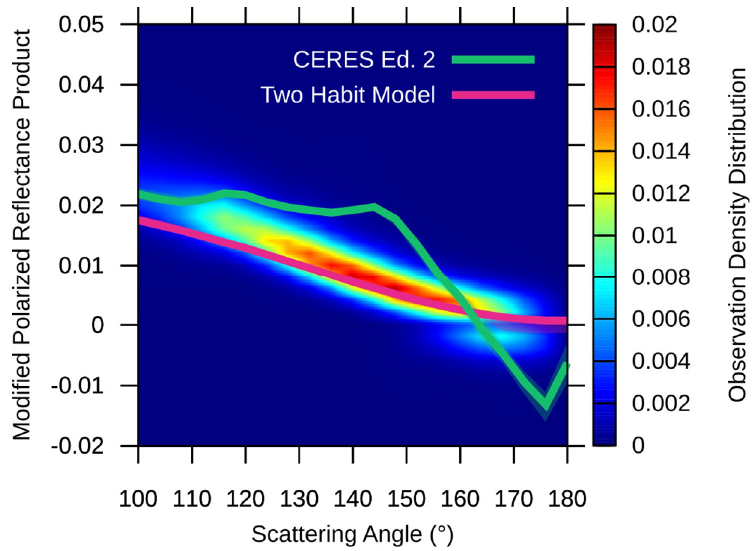
Figure 15. Comparison between observed modified polarized reflectance product values and the simulations based on the two-habit and CERES Edition 2 ice cloud models.